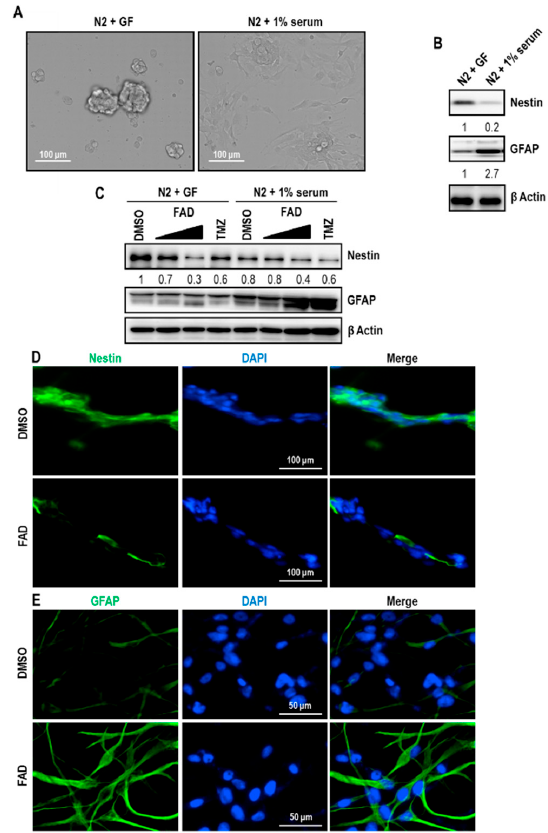
Figure 2. Downregulation of the stemness of glioblastoma stem-like cells by FAD treatment ( A ) Cell morphology of U373 glioblastoma cells in two different culture conditions. For the enrichment of glioblastoma stem-like cells, cells were maintained under N2 culture media supplemented with 20 ng/mL EGF and bFGF (N2+GF). Spheres are maintained with N2 media including 1% fetal bovine serum (FBS) for differentiation induction (N2 + 1% serum). ( B ) Western blot analysis of Nestin and GFAP in undifferentiated or differentiated glioblastoma cells. β Actin was used as a loading control. The relative band intensities of Nestin and GFAP proteins are shown below the bands. The intensities of N2+GF lane were arbitrarily set as 1. ( C ) Western blot analysis of Nestin and GFAP in undifferentiated or differentiated glioblastoma cells after treatment of DMSO, FAD (10 μ M, 40 μ M), and TMZ (200 μ M) for 3 days. β Actin was used as a loading control. The relative band intensities of Nestin are shown below the bands. The intensities of vehicle treated lane were arbitrarily set as 1. ( D and E ) Immunofluorescence analysis of Nestin ( D ) and GFAP ( E ) expression in DMSO or FAD treated cells. Nuclear DAPI (4 ′ ,6-diamidino-2-phenylindole) staining is in blue. These are representative results of counting 10 random fields of view in each group.